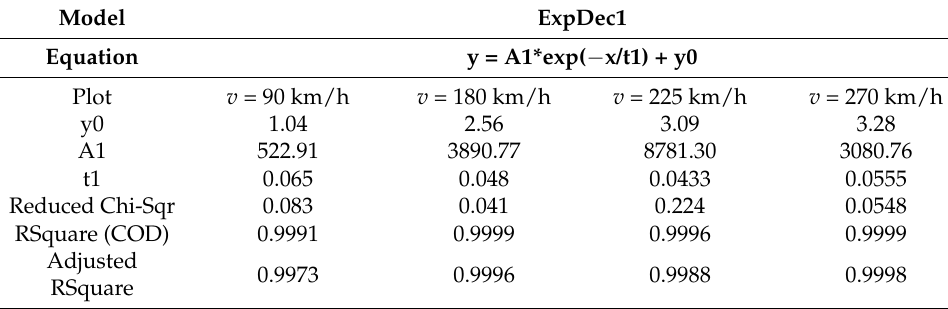
Table 6. Data fitting results of peak